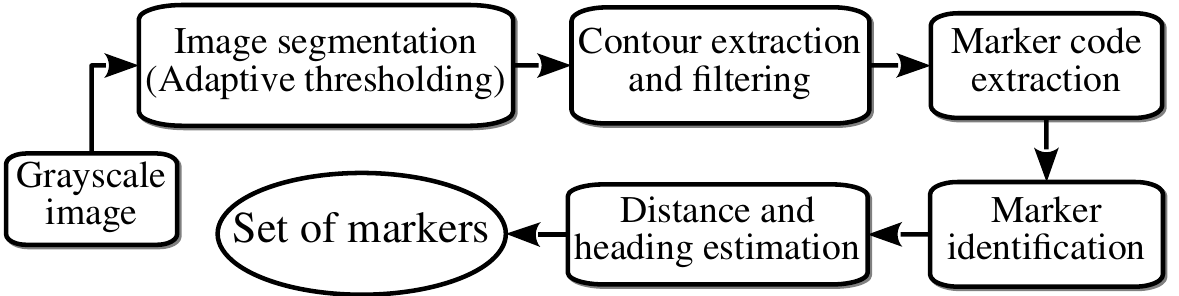
Figure 4. Flowchart of the procedure for detecting the Aruco markers surrounding the underwater